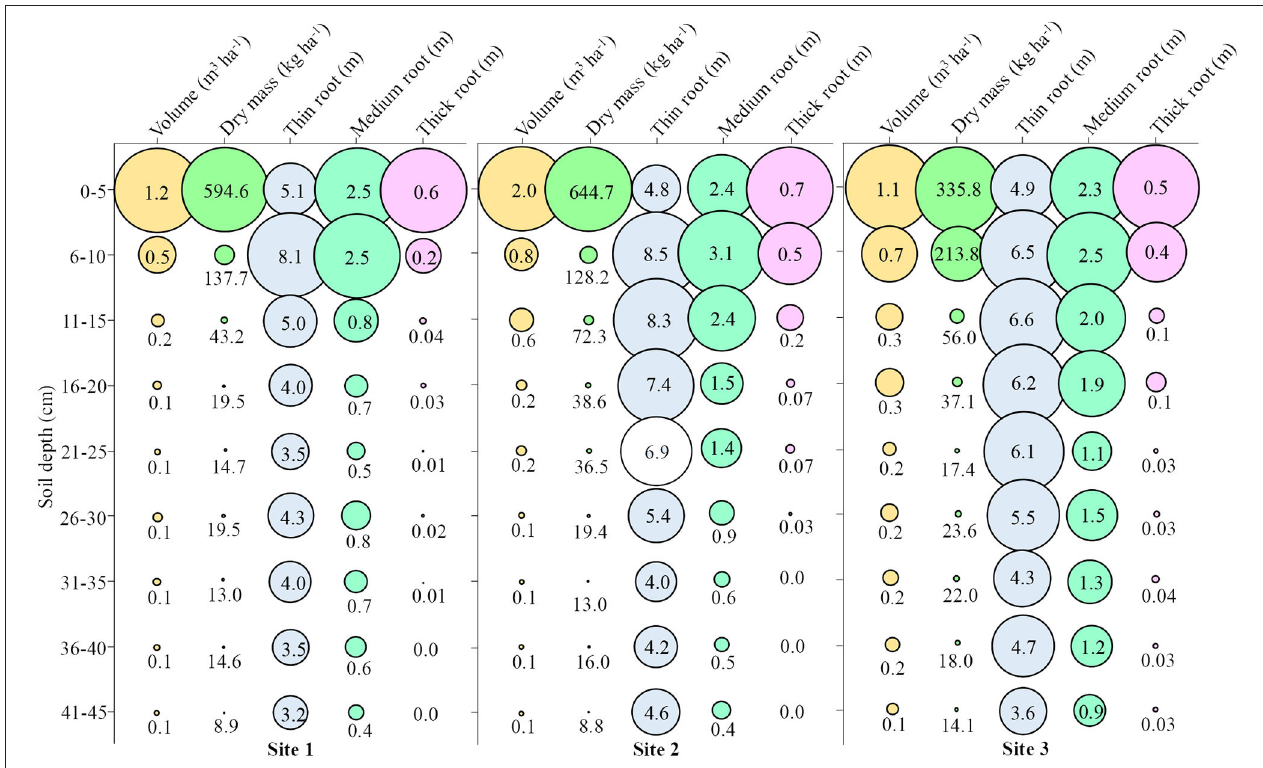
FIGURE 8 | Attributes of root growth in soybean in Site 1, Site 2, and Site 3 at different soil depths. Fine roots ( < 0.5mm); Medium roots (0.5–2mm); Thick roots ( >